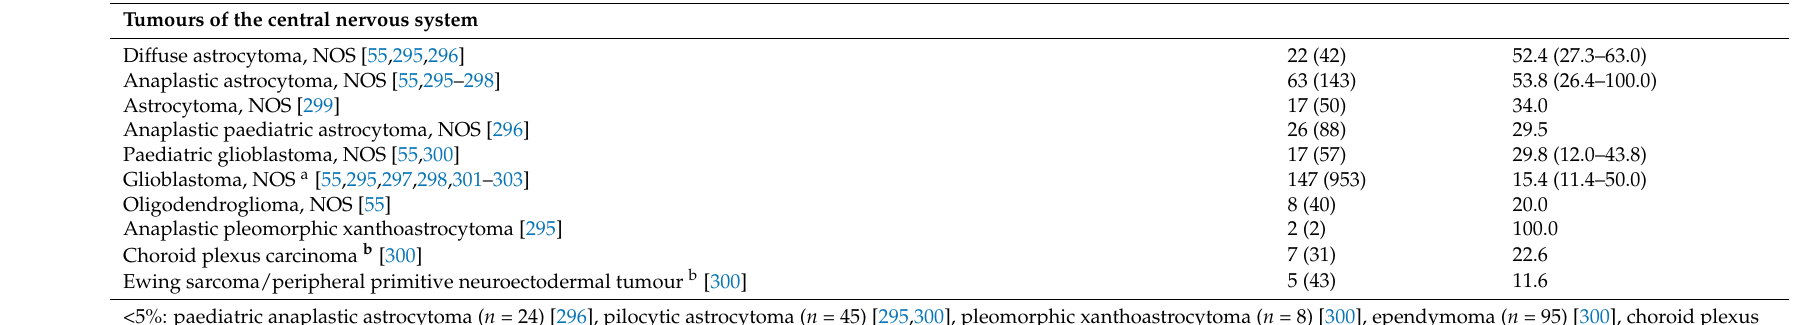
Table 4. Prevalence of alternative lengthening of telomeres (ALT) in human tumours. Only the tumour histotypes associated with ALT-positive phenotype in a frequency ≥ 5% will appear in the following table together with its respective number, percentage, and range of mutated cases. Whenever the tumour histotypes were associated with a low rate of ALT-positive phenotype (<5%) only the total of patients will be shown (complete data available in Supplementary Table S1). Tumour Type Positive Cases (Total) Positive Cases in % (Range) Tumours of the breast Absence of histotypes with a frequency of ALT equal or higher than